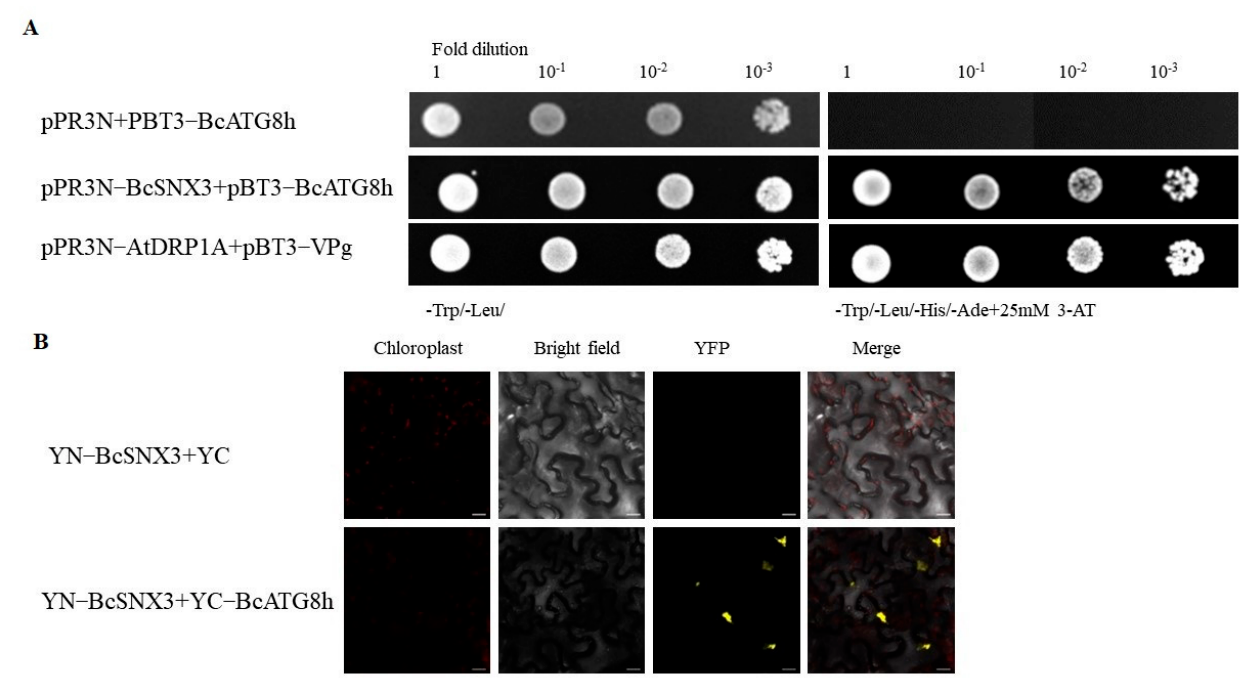
Figure 4. Co-localization of BcSNX3 with the autophagosome marker BcATG8b in N. benthami- ana . Fluorescence images of YFP, CFP, and merged were captured through confocal laser scanning microscopy and are displayed in green, red and orange, respectively. Bars, 20 µ m.